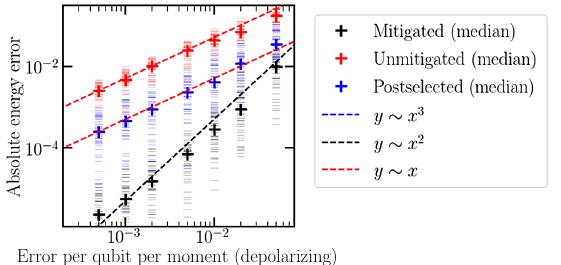
FIG. 12. Comparison between verified phase estimation and symmetry verification. Both techniques are compared to the estimation of the expectation value of the electronic structure Hamiltonian for H 2 under a depolarizing noise model.